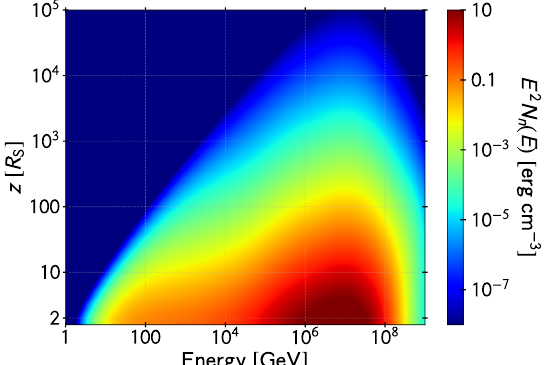
Figure 5. Energy distribution of neutron injection in the accretion flow for the fiducial model discussed in the text. The thin lines show the contribution from different parts of the flow; the darker blue curves are located closer to the black hole than the lighter yellow curves. The total contribution summing all regions in the flow is shown as dashed red lines ( p γ ) and green dot-dashed lines ( pp ). The dark solid line is the total injection function.